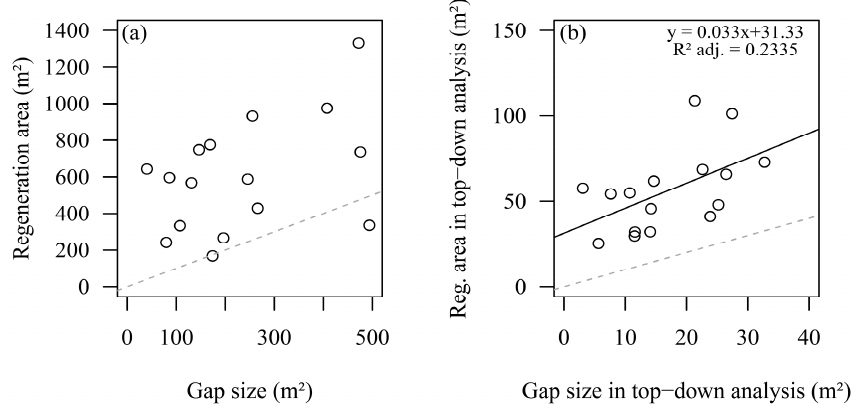
Figure 5. Scatterplots of regeneration area (m 2 ) over gap size (m 2 ). ( a ) Non-significant relationship between gap size and resulting regeneration area based on polygon analysis. ( b ) Significant relationship between gap size and regeneration area based on raster data in top-down analyses. The dashed grey dashed grey lines mark the 1:1 relationship between both sizes. lines mark the 1:1 relationship between both